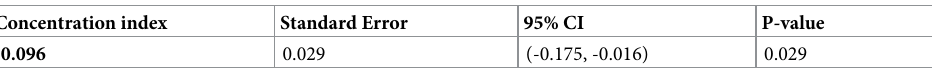
Table 2. Value of the concentration